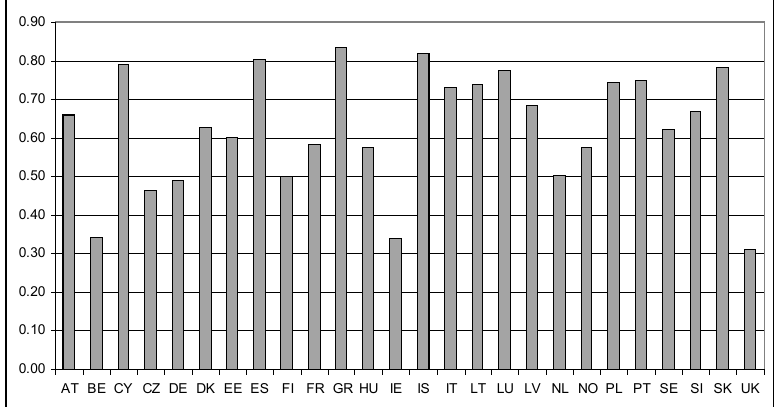
Figure 3 : Proportion of children in poverty who have a parent in full-time employment 0.300.400.500.600.700.800.90 0.000.100.20